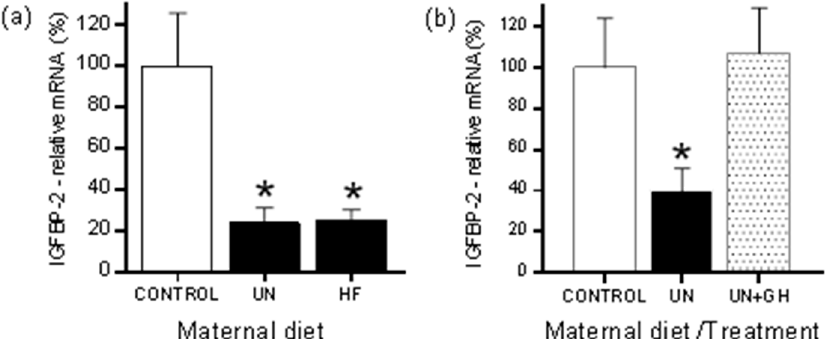
Figure 1. Hepatic insulin-like growth factor binding protein 2 (IGFBP-2) expression in ( a ) adult male offspring from mothers either undernourished (UN) or fed high fat (HF) diets during pregnancy as compared to offspring from normally nourished mothers; ( b ) hepatic IGFBP-2 expression in adult male offspring of UN mothers treated with growth hormone (GH) during the pre-weaning period. * p < 0.05 versus Control. Data are mean ± standard error of the mean (SEM), n = 10 per group. Note that the UN groups shown for ( a , b ) are derived from independent animal cohorts. Figure 1a reimaged from [63].